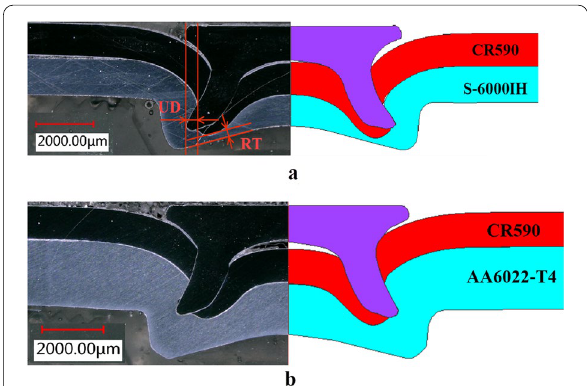
Figure 7 Comparison of the joint cross-sectional profiles from the simulations and experiments ( a ) SPR-A joint, ( b ) SPR-B joint